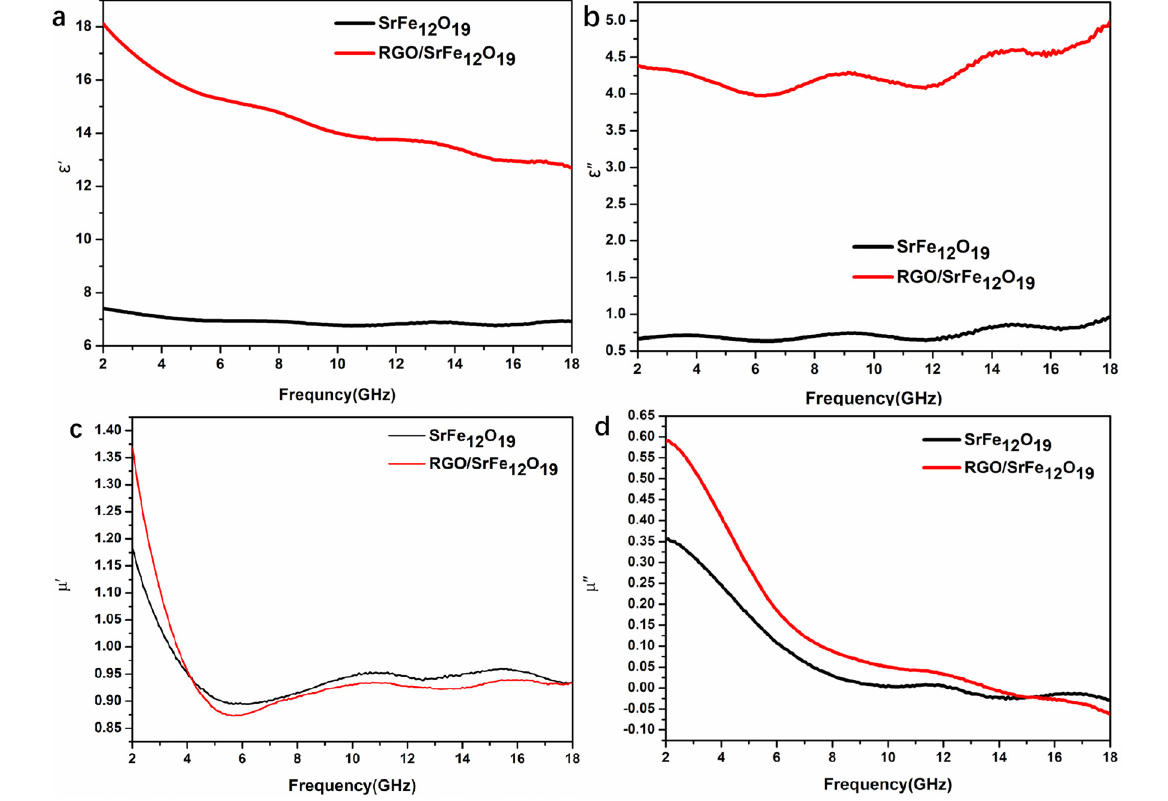
Figure 4: Frequency dependence of (a) real part of permittivity ( ε ′ ); (b) imaginary part of permittivity ( ε ′′ ); (c) real part of permeability ( µ ′ ); (d) imaginary part of permeability ( µ ′′ ) of SrFe